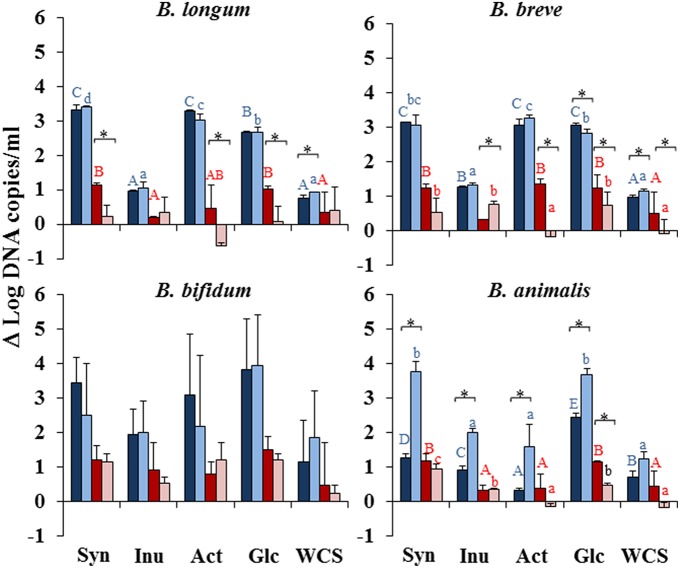
Increments, with respect to time zero, on the levels (Log CFU/mL) of the strains when grown in mono-culture (Bifidobacterium dark-blue column and C. difficile dark-red) or co-culture (Bifidobacterium light-blue and C. difficile light-red column) in the prebiotics Synergy (Syn), Inulin (Inu), and Actilight (Act), in glucose (Glc) or without any carbon source added (WCS). Different capital letters above columns denote statistically significant differences (p < 0.05) among carbon sources in the mono-cultures of the corresponding bacterial strain, whereas different lowercase letters indicate differences in the co-cultures (either Bifidobacterium in blue letters or C. difficile in red letters). *Indicates statistically significant differences (p < 0.05) for the corresponding bacterial strain between mono- and co-culture within the same substrate.